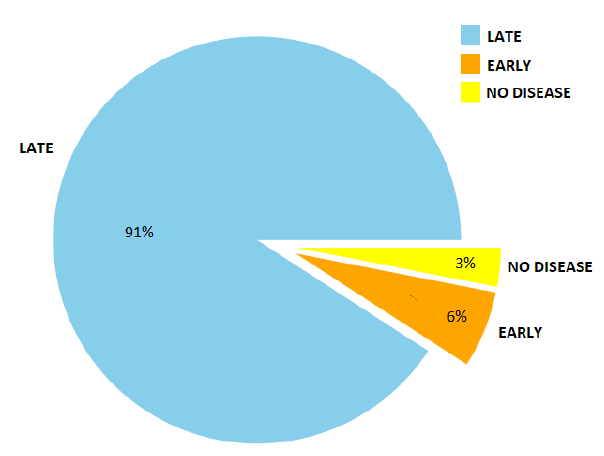
Figure 7. Categorical distribution of the target